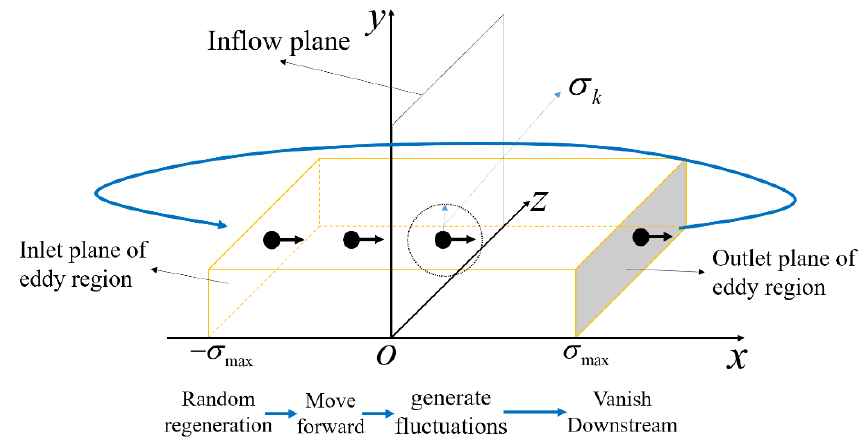
 in Figure 4. It is defined as: 3